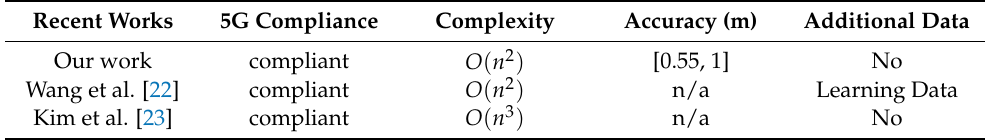
Table 2. Performance and complexity